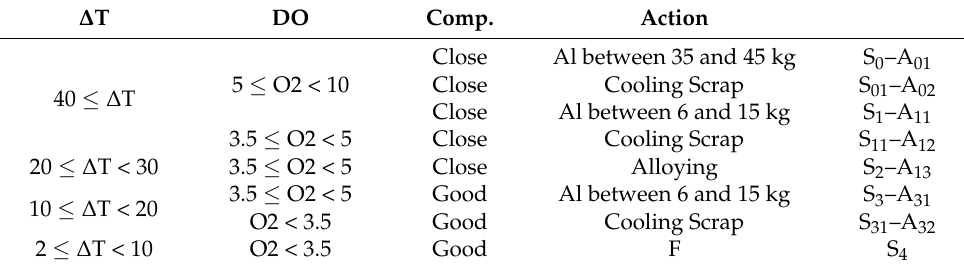
Table 7. Final result of episodes generation.